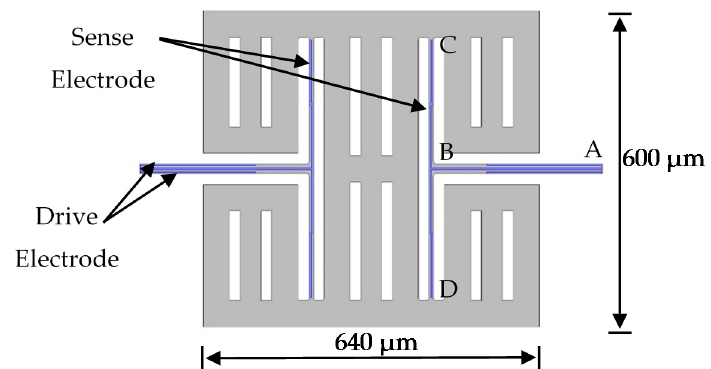
Figure 3. The schematic of aluminum nitride (AlN) microelectromechanical systems (MEMS) gyroscope.